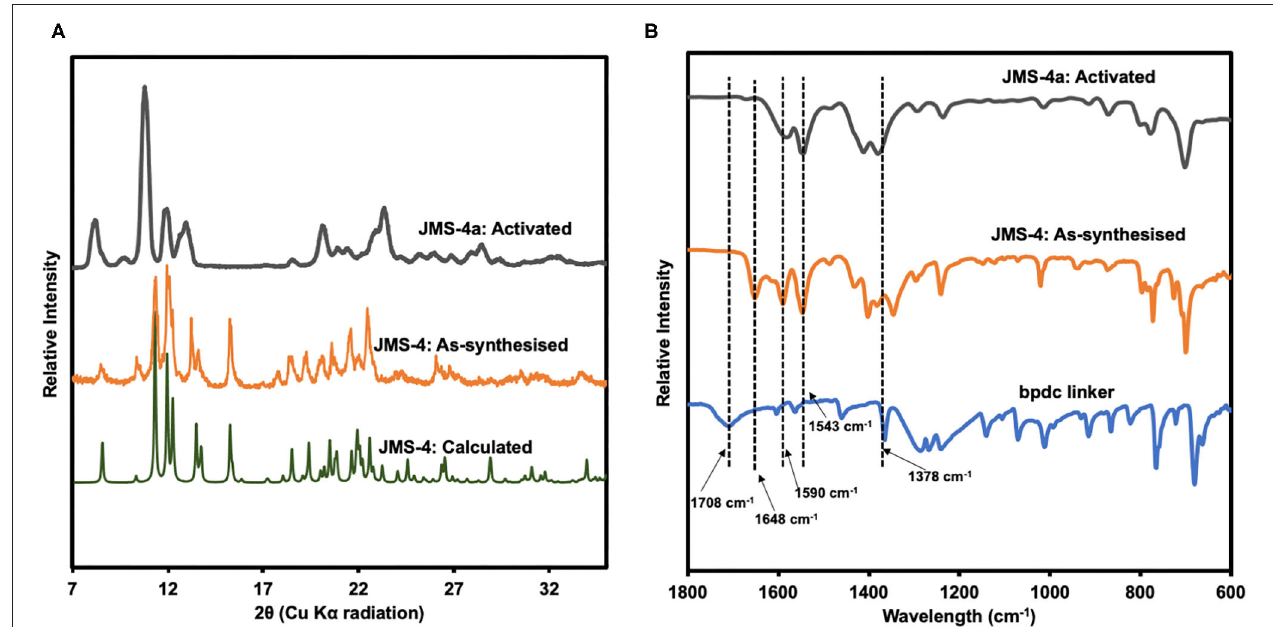
FIGURE 6 | (A) PXRD patterns of calculated, experimental and activated JMS-4, (B) IR spectrum of the linker, as-synthesized and activated JMS-4.